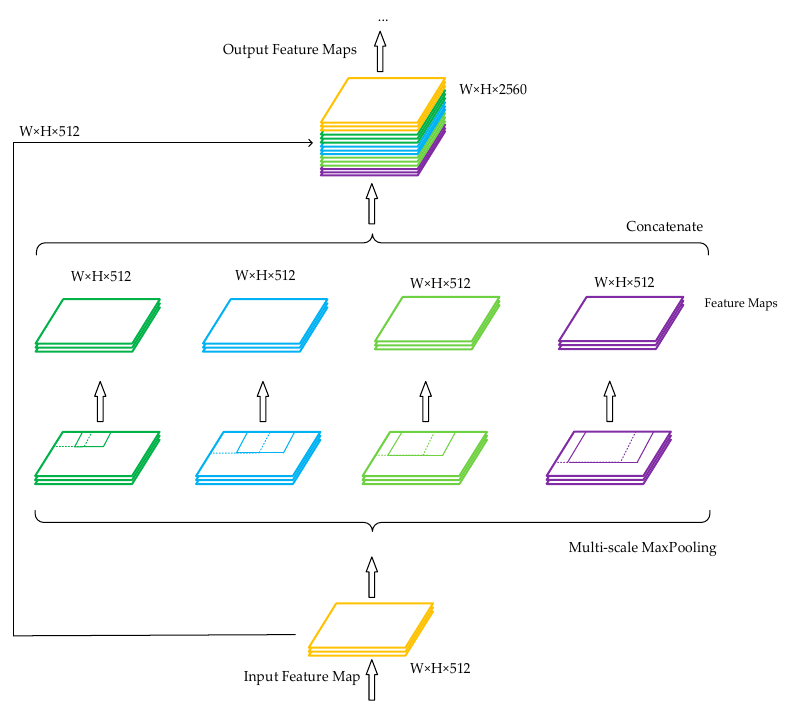
Figure 5. Improved dense spatial pyramid